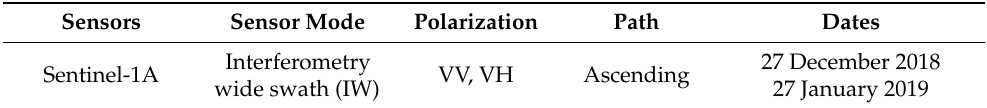
Table 1. Description of Sentinel-1